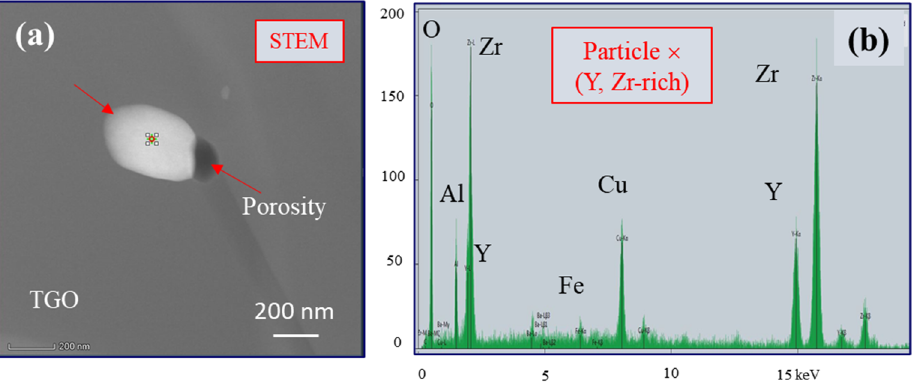
Figure 5. ( a ) STEM image and ( b ) EDS spectra of Zr(Y) rich particle embedded in Al 2 O 3 (I) grain.